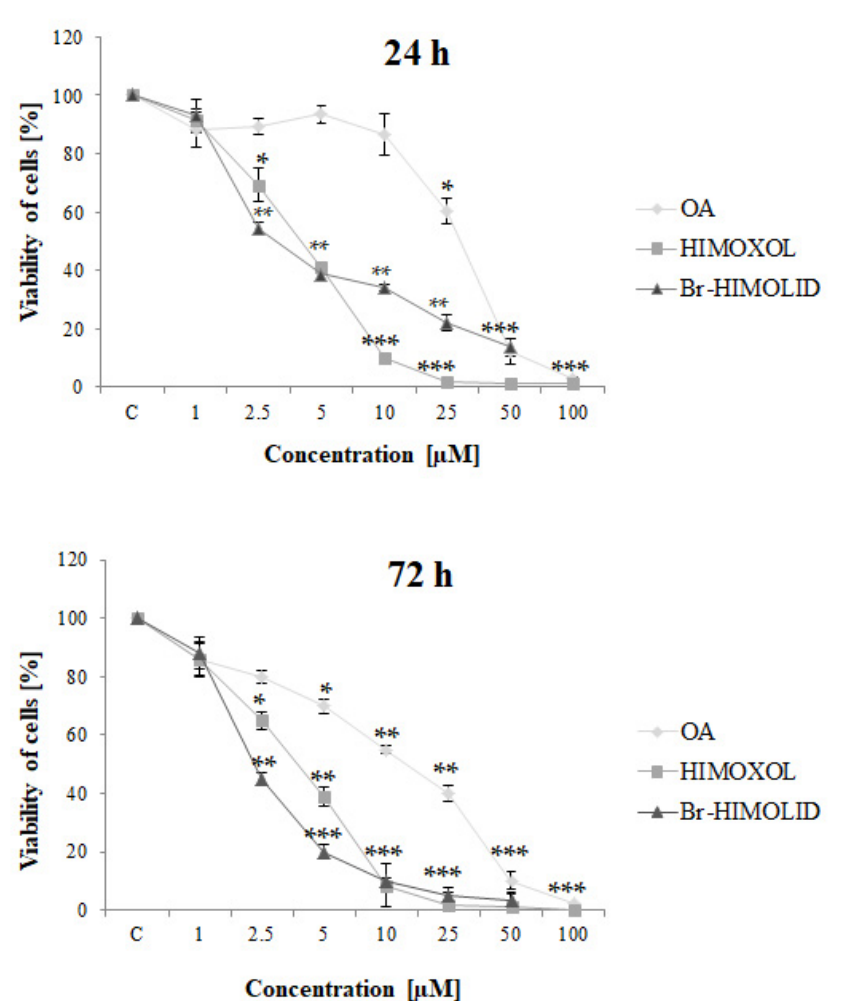
Figure 3. Contribution of oleanolic acid and its derivatives to breast cancer cells viability. SK-BR-3 cells were treated for 24 or 72 h with a high range of concentrations of studied compounds, i.e., 1–100 µM. The mean of three experiments ± SD is shown. Statistically significant difference versus control samples is shown: * p < 0.05; ** p < 0.005; *** p < 0.001.